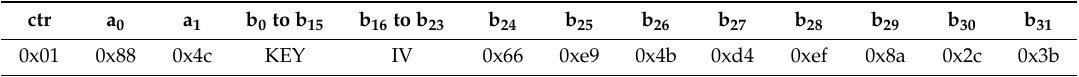
Table 1. Initial values of the Enocoro-128v2 according to the